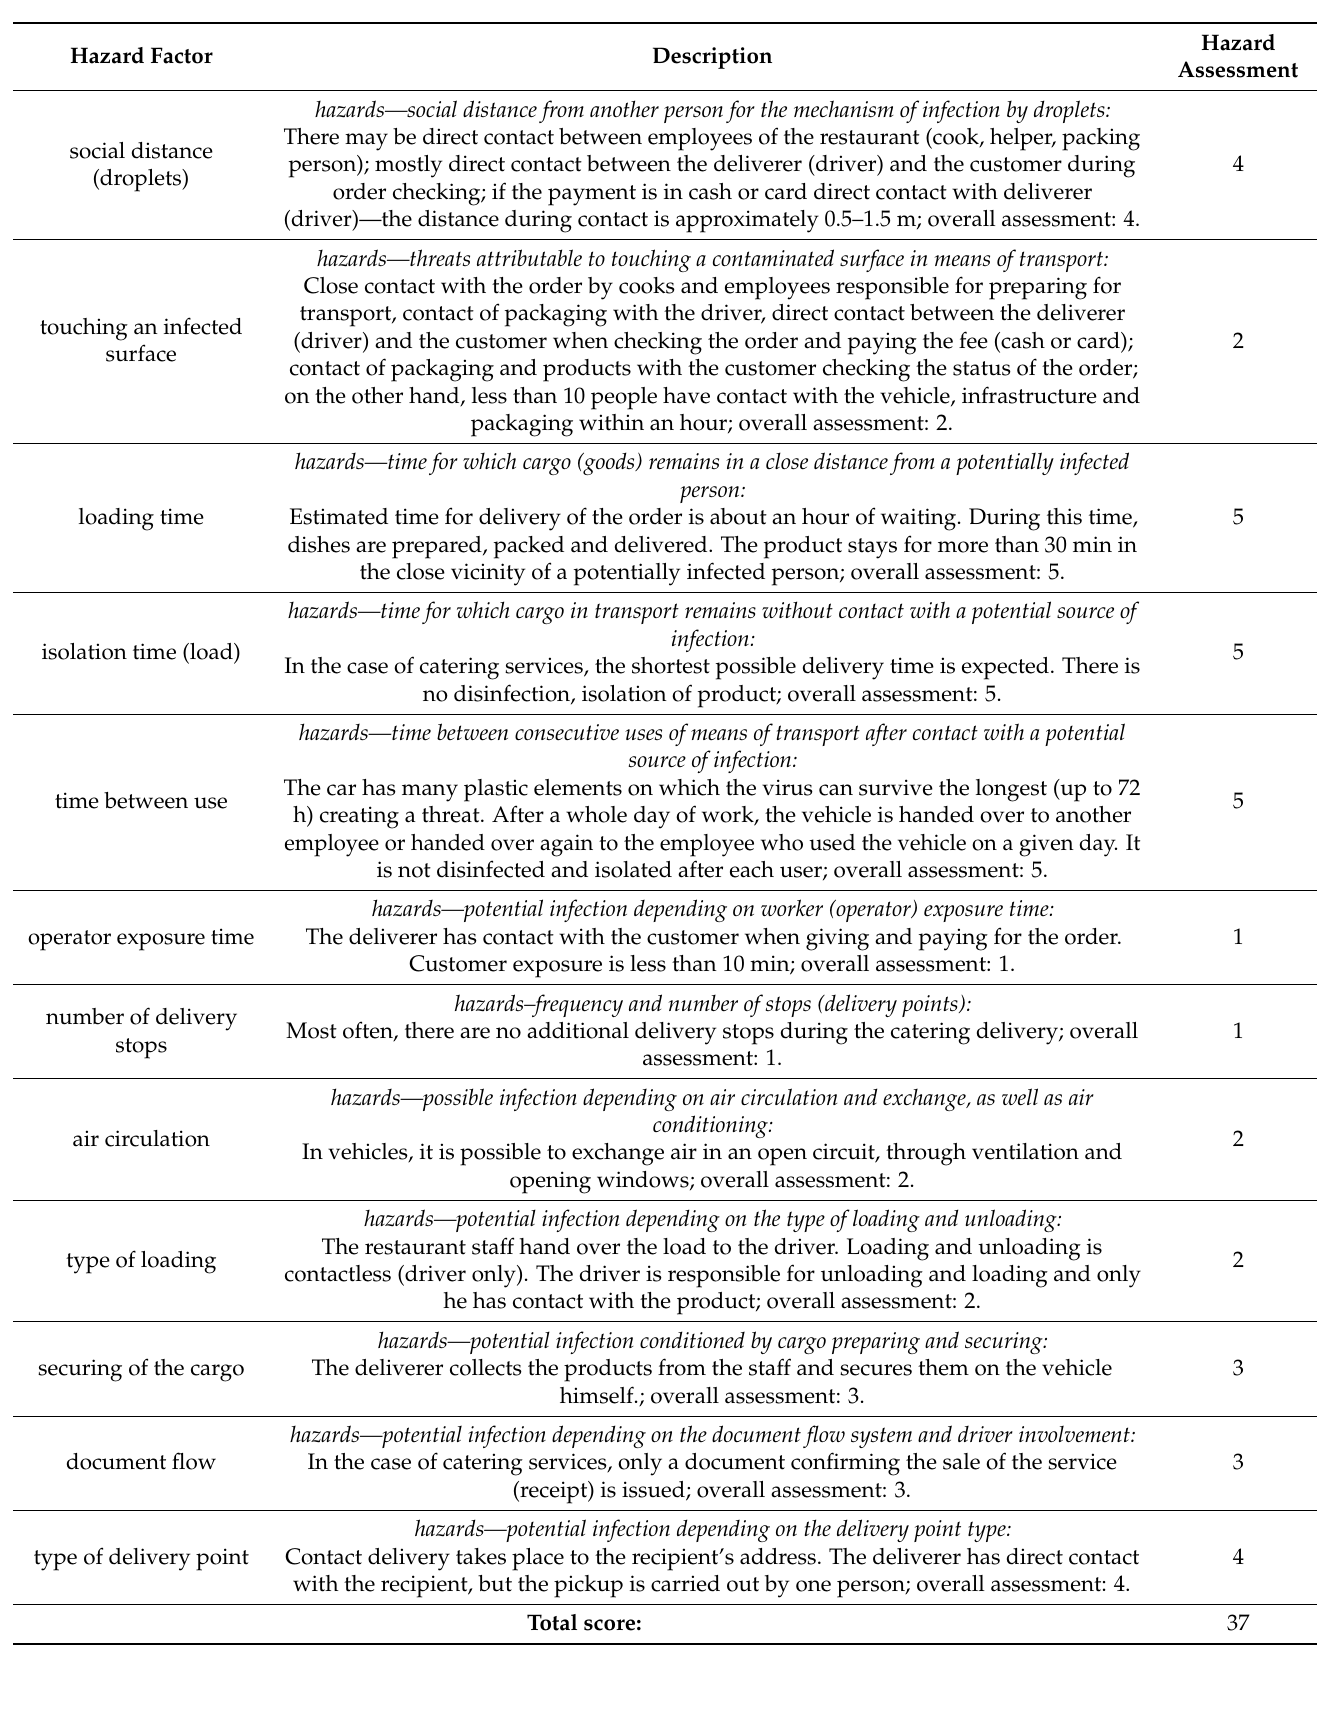
Table 5. Assessment of epidemic hazards due to criteria of the DHI methodology—catering